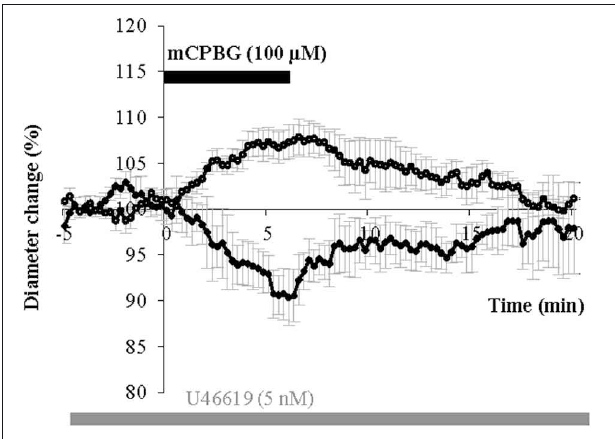
FIGURE 8 | mCPBG induces vasodilations and vasoconstrictions in Pet1 − / − mice. Mean vasodilation ( n = 6) and vasoconstriction ( n = 3) induced by mCPBG (100 μ M) in Pet1 − / − mice.